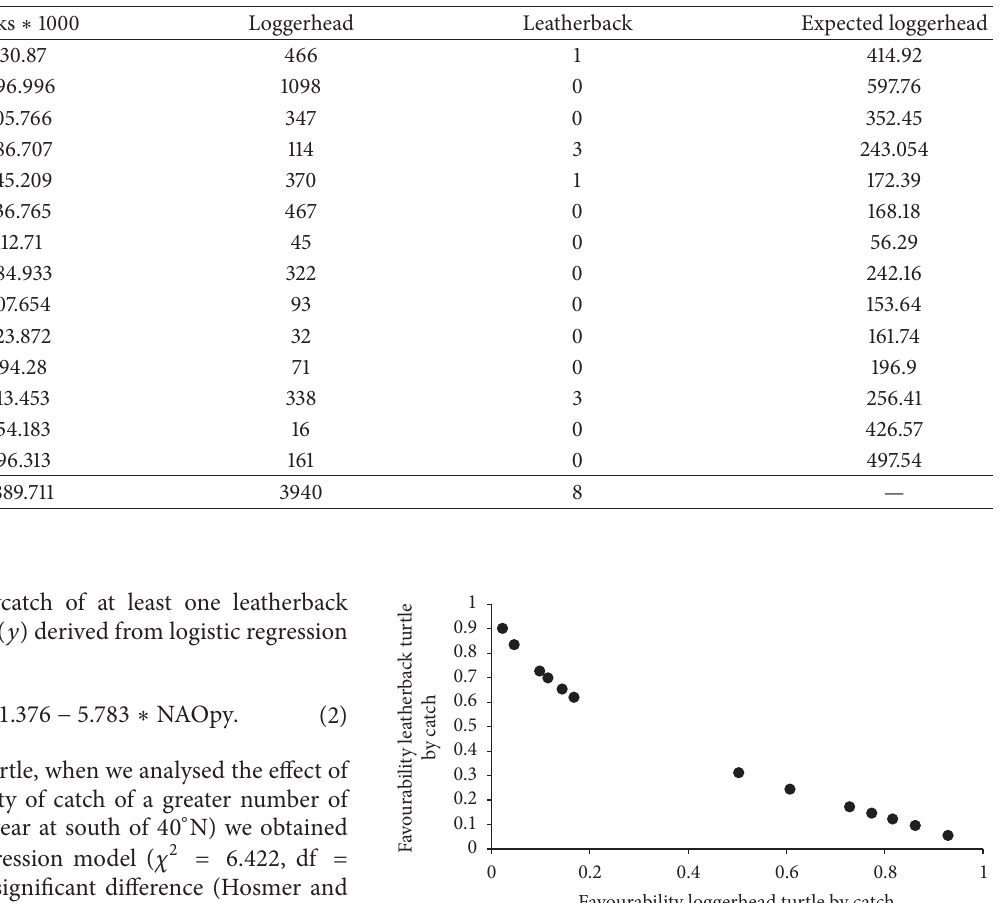
Table 1: Observed hooks and turtle bycatch per year during the study period. Expected loggerhead values were calculated according to the number of hooks, and thus the expected loggerhead is (total loggerhead turtles observed in all the study period ∗ the total hooks observed in the year)/total hooks observed in all the study period.